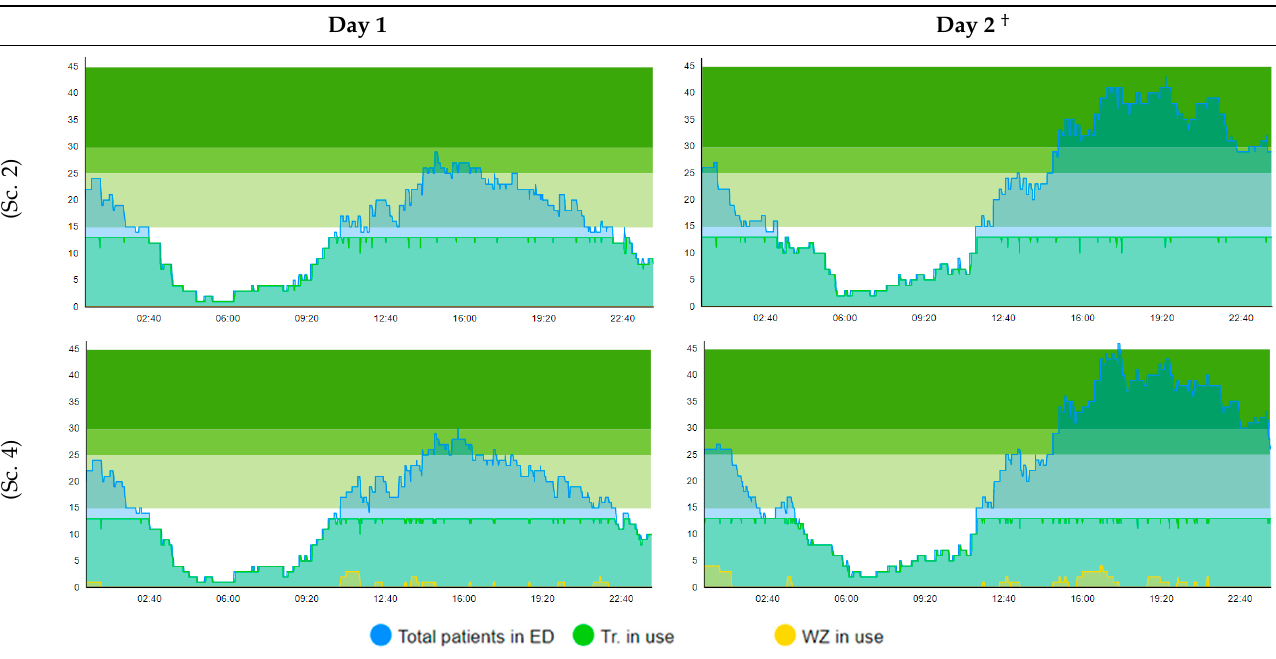
Table 12. Simulation output crowding graphs for comparing Sc.4 with Sc.2.